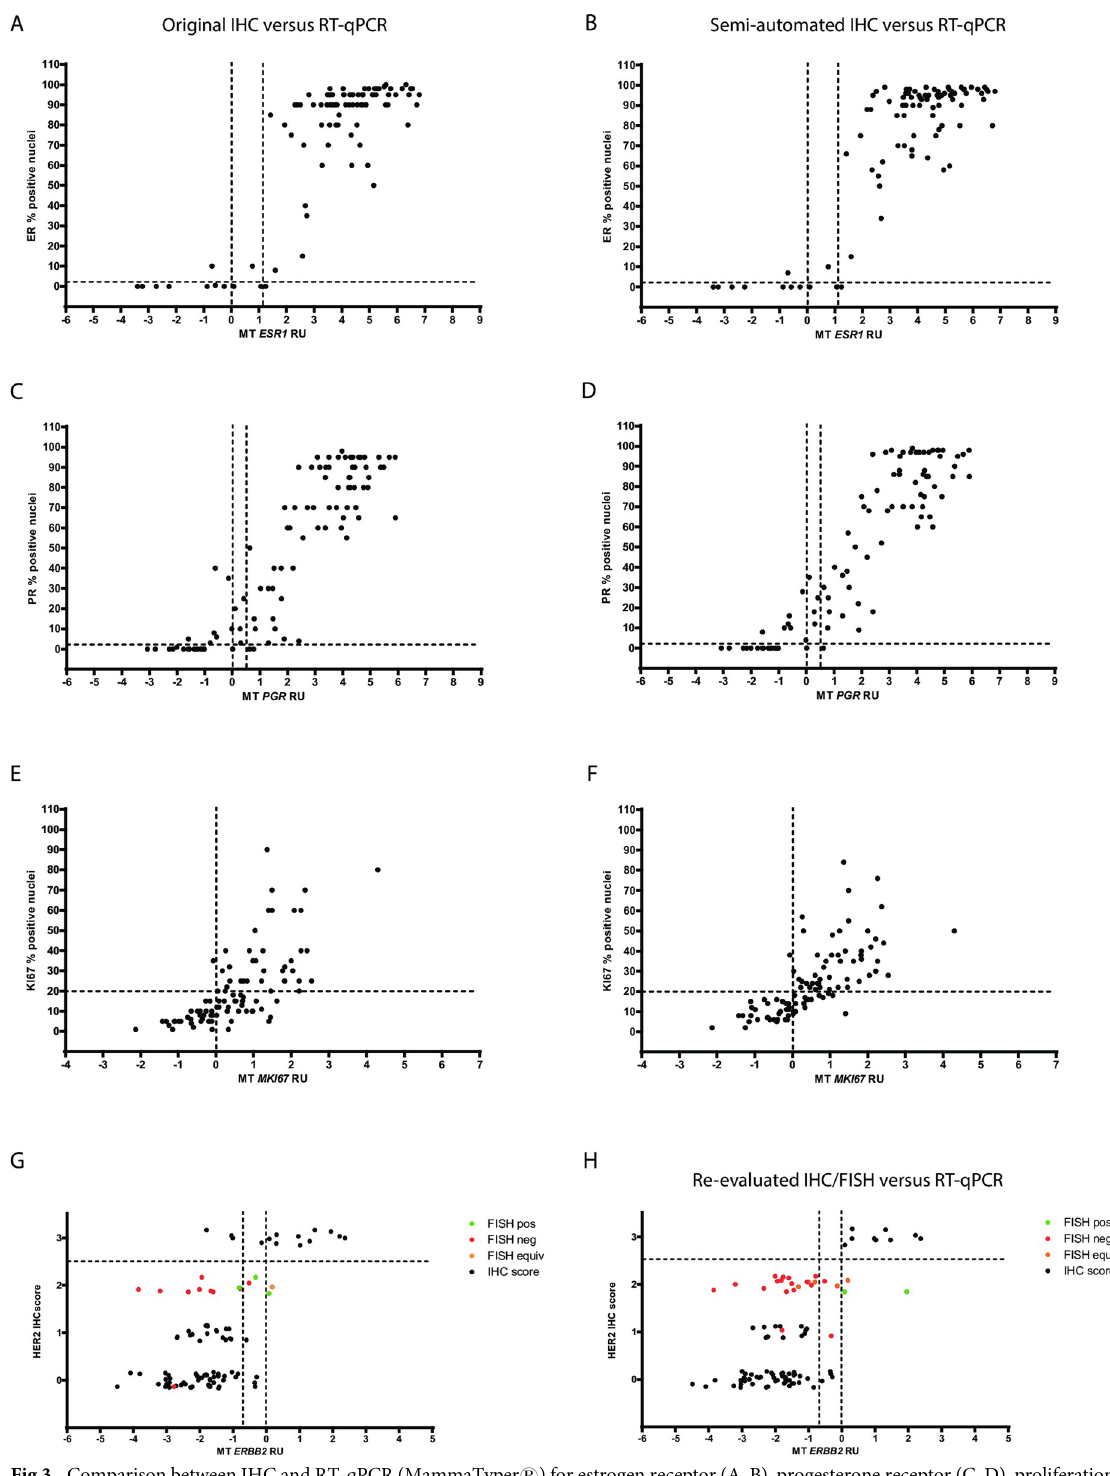
Fig 3. Comparison between IHC and RT-qPCR (MammaTyper 1 ) for estrogen receptor (A, B), progesterone receptor (C, D), proliferation marker Ki67 (E, F) and human epidermal growth factor receptor 2 (G, H). Scatterplots with ORI IHC ER scores (A) or DIA IHC ER score (B) on the y-axis and ESR1 RU values on the x-axis. Cut-off values at 1% for IHC and 0.0 RU for RT-qPCR are shown by black dotted lines. Scatterplots with ORI IHC PR scores (C) or DIA IHC PR score (D) on the y-axis and PGR RU values on the x-axis. Cut-off values at 1% for IHC and 0.0 RU for RT-qPCR are shown by black dotted lines. Scatterplots with ORI IHC Ki67 scores (E) or DIA IHC Ki67 score (F) on the